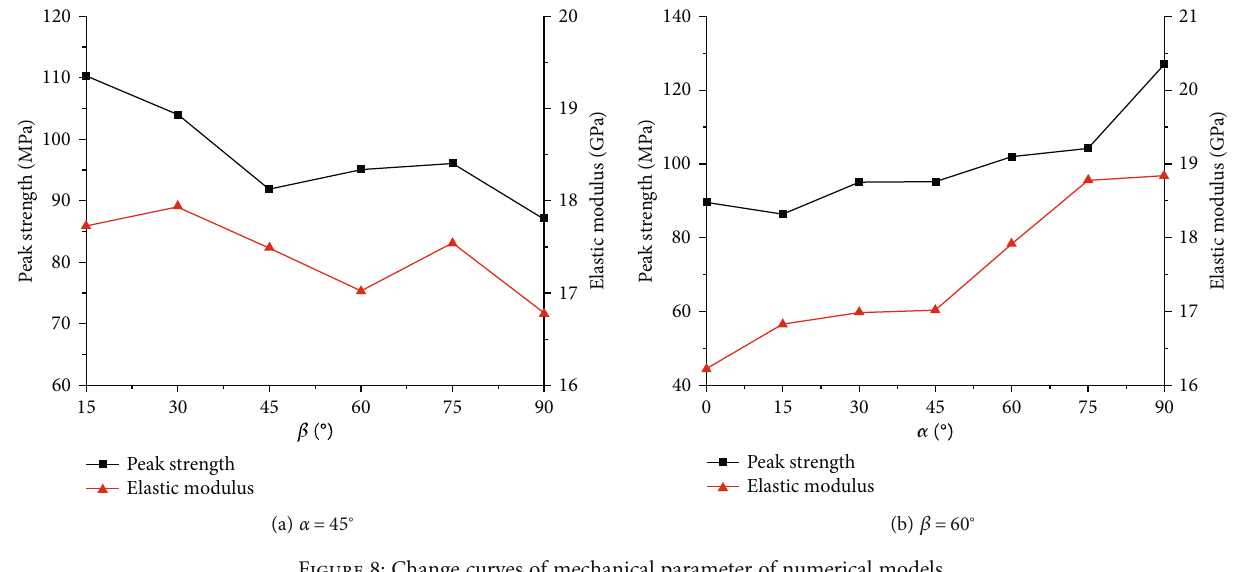
Figure 8: Change curves of mechanical parameter of numerical models. Table 4: The crack initiation stress and damage stress of numerical